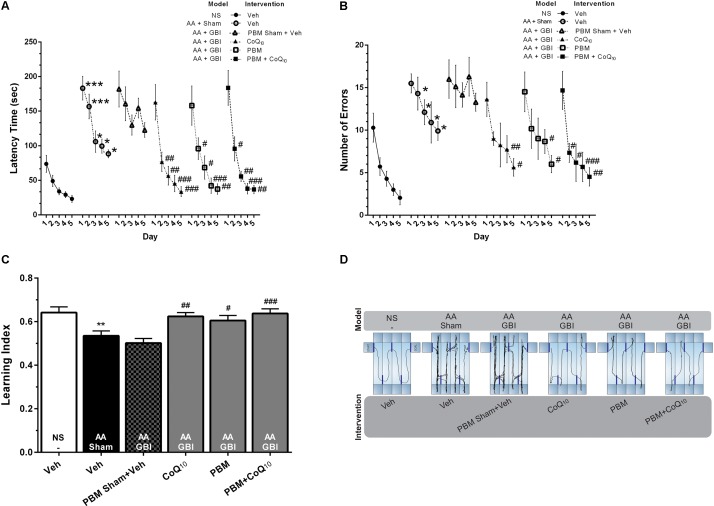
(A) Latency times and (B) number of errors in different groups. Differences among groups were analyzed for each day. (C) Learning index in different groups. (D) Corresponding sample tracks display the exploratory patterns during the last day of test. Values represent the mean ± SEM, (n = 15). ∗p < 0.05, ∗∗p < 0.01, and ∗∗∗p < 0.001 compared with the NS (control). #p < 0.05, ##p < 0.01, and ###p < 0.001 compared with the AA + GBI. AA, artificially aged; CoQ10, Coenzyme Q10; GBI, global brain ischemia; NS, normal saline; PBM, photobiomodulation; Veh, Vehicle.